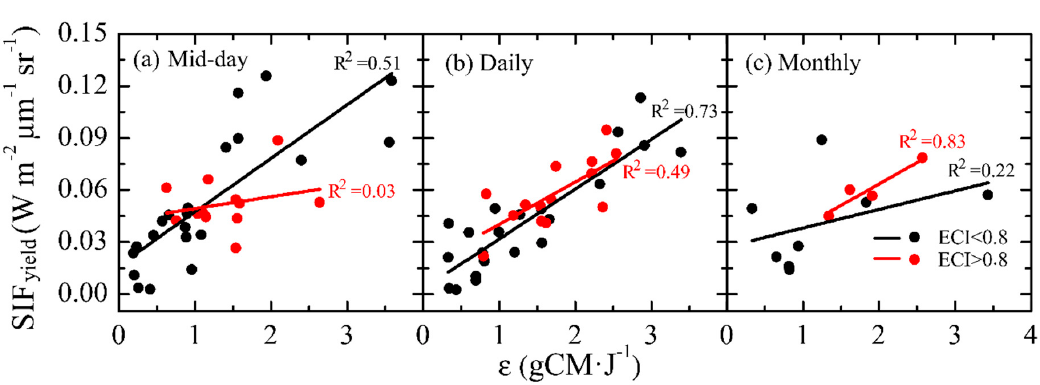
Figure 7. Relationship between SIF yield (SIF / APAR, SIF yield ) and light-use e ffi ciency ( ε ) at the satellite overpass time throughout 2015 at the CN-YuC cropland site in northern China, where 0.8 is the threshold value at which ECI values are fit separately for the mid-day, daily, and monthly timescales, respectively. The whole canopies are prone to experiencing exposure to excess light when the ECI is greater than 0.8 compared with when the ECI is lower.